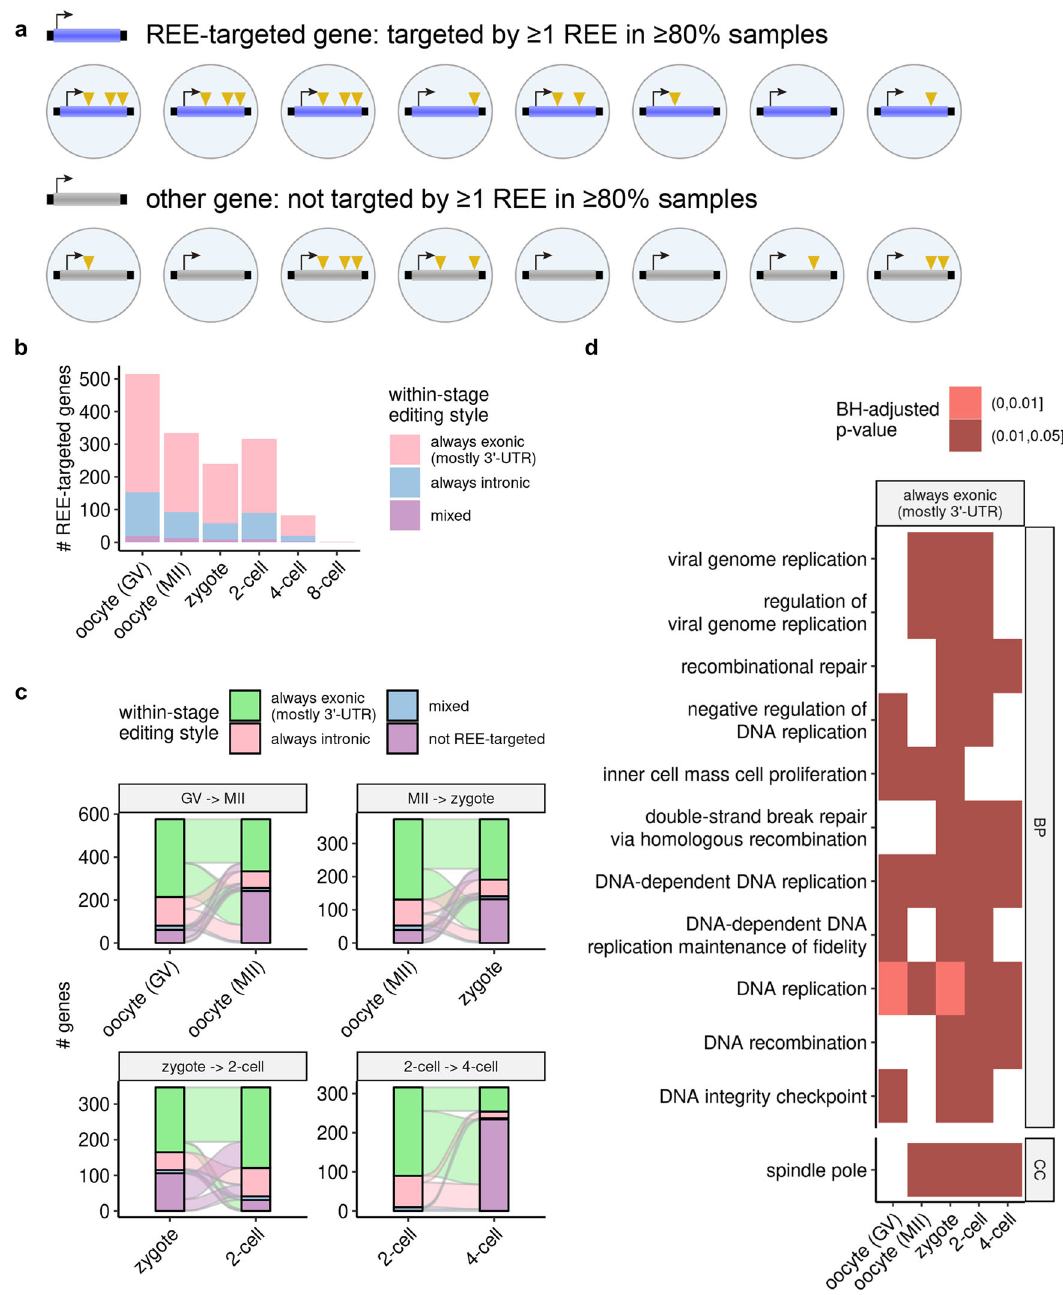
Fig. 3 REEs target similar genes enriched with DNA replication-related functions across the early stages of embryogenesis. a De fi nition of REE-targeted genes. Note that for further fi ltering for more reliable results, we used a more stringent criterion (edited by at least one REE in ≥ 80% of samples) than used for the de fi nition of REEs. b Counts of REE-targeted genes per stage. c Sankey plot describing the number of REE-targeted genes passed to subsequent early stages. For clarity, only REE-targeted genes observed in at least one of the two stages appear in each subplot. d Cross-stage ( ≥ 3 stages) enriched functions of REE-targeted genes. Note that we performed enrichment analyses on 3'-UTR- and intronic-REE-targeted genes separately, and discovered cross-stage enriched functions only for the former (Methods). All p values were Benjamini – Hochberg-adjusted